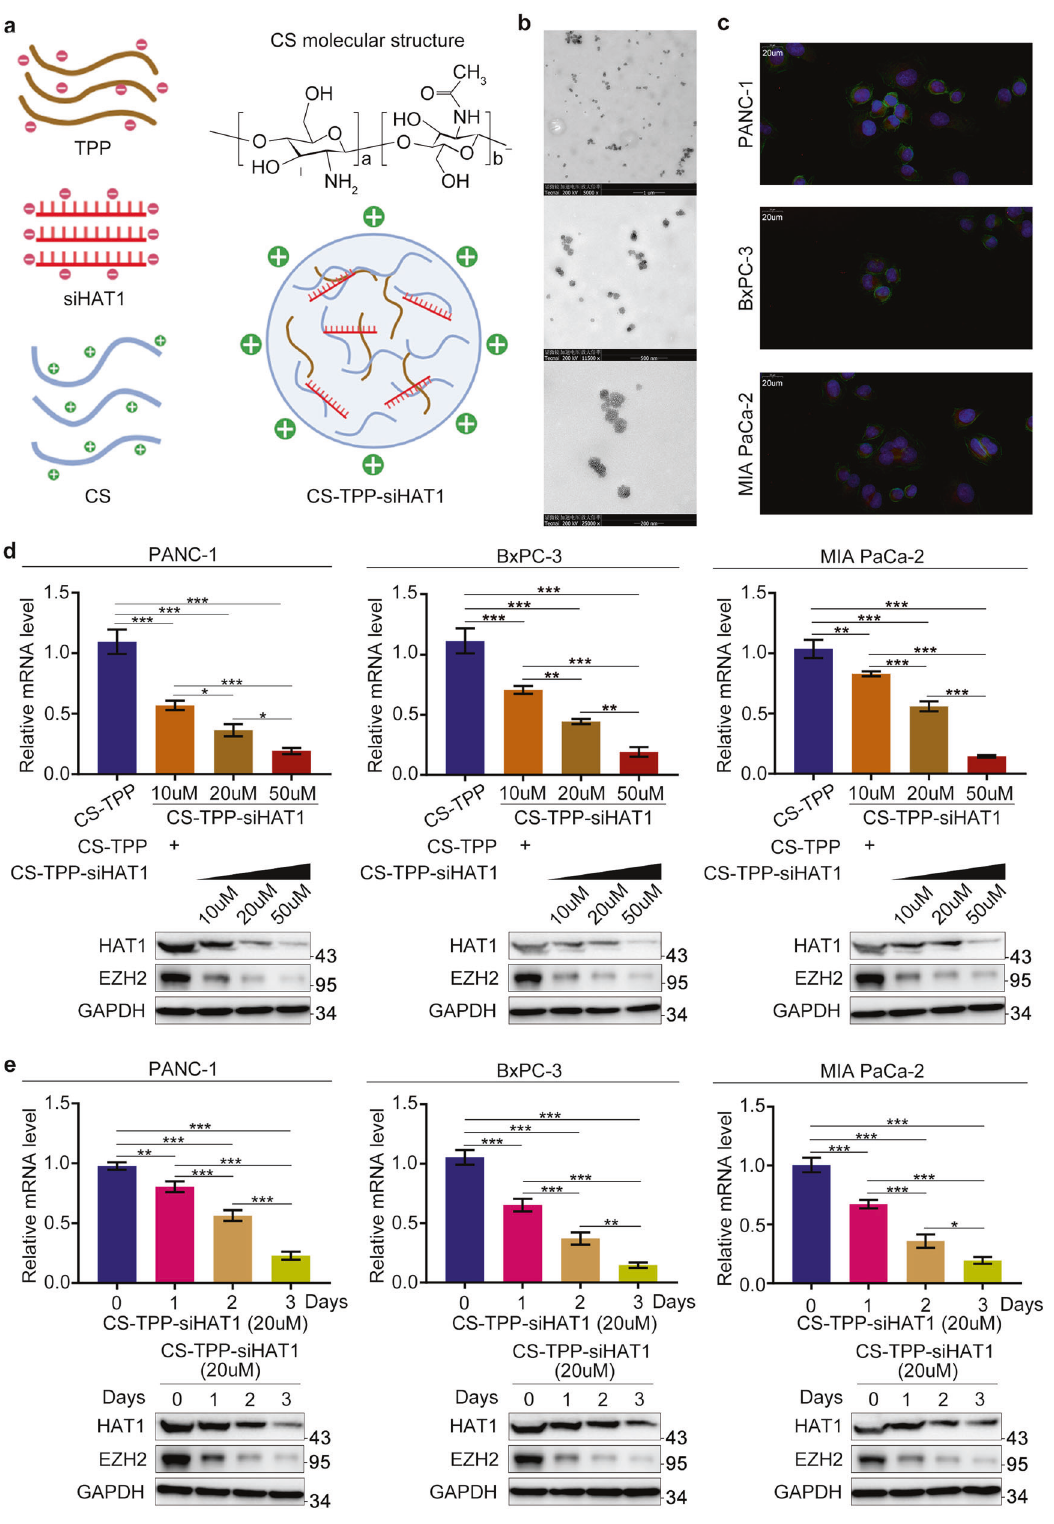
Cell proliferation and colony formation assay The MTS (3-(4,5-dimethylthiazol-2-yl)-5-(3-carboxymethoxyphenyl)-2-(4- sulfophenyl)-2H-tetrazolium) reagent (ab197010, Abcam, USA) was used to assess cell proliferation in vitro. Cells were seeded in 96-well plates (2000 cells in 100 μ l DMEM per well) and cultured for 3 days.